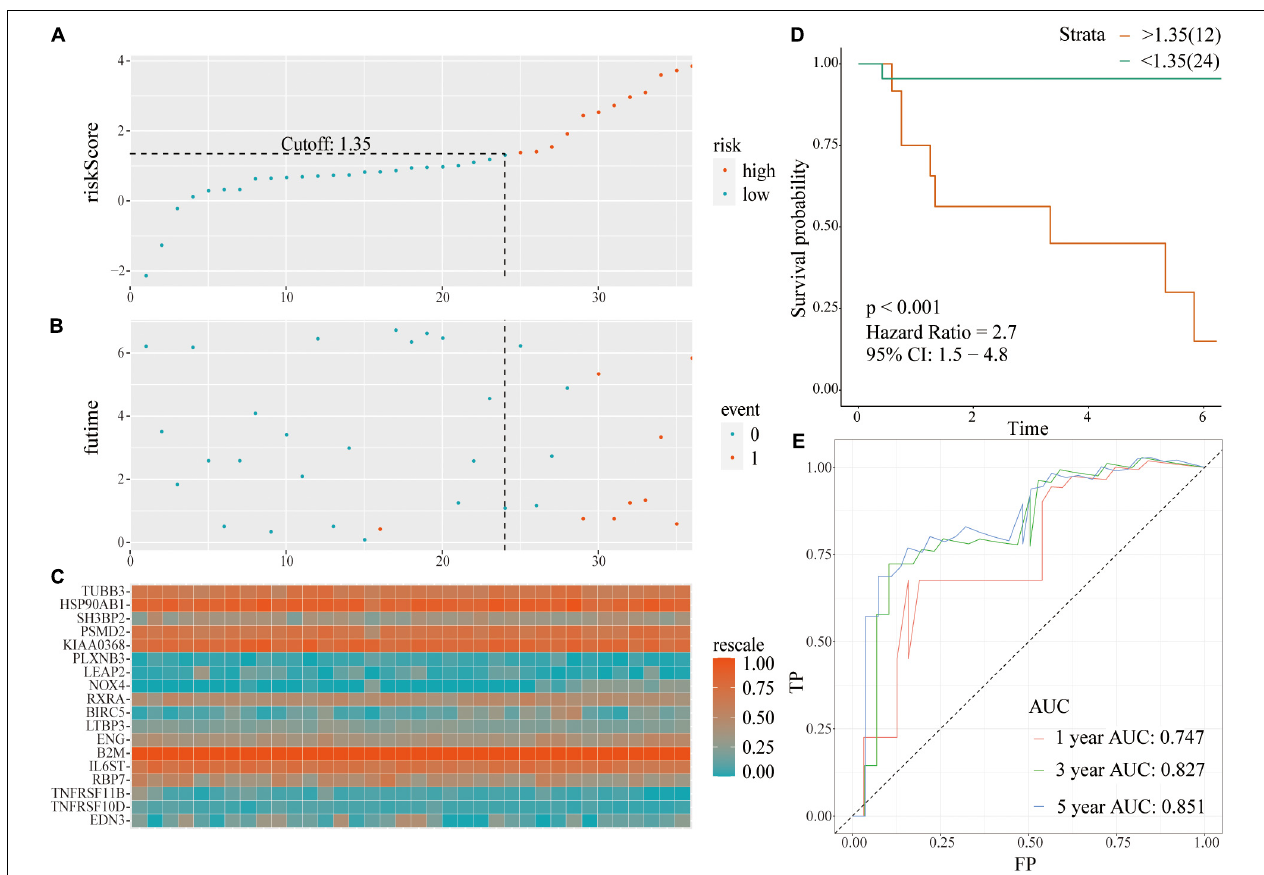
FIGURE 5 | A prognostic signature based on IRGs in independent validation dataset. (A) Distribution of risk scores based on IRGs in PCa; (B) Recurrence status of patients in different groups; (C) Heatmap showing the expression profiles of IRGs; (D) Survival analysis for the signature-defined risk groups; (E) Time-dependent ROC curve of the 18-IRGs prognostic signature. TABLE 3 | Univariate and multivariate analyses of prognostic factors in the TCGA Data set, and independent validation data set. Characteristics Univariate Multivariate Hazard.Ration CI95 P- value Hazard.Ration CI95 P -value TCGA dataset Risk